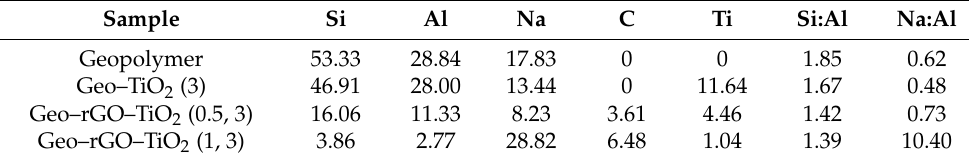
Table 3. Atomic ratio of Si:Al and Na:Al at the outer layers of the samples, in at.%. Sample